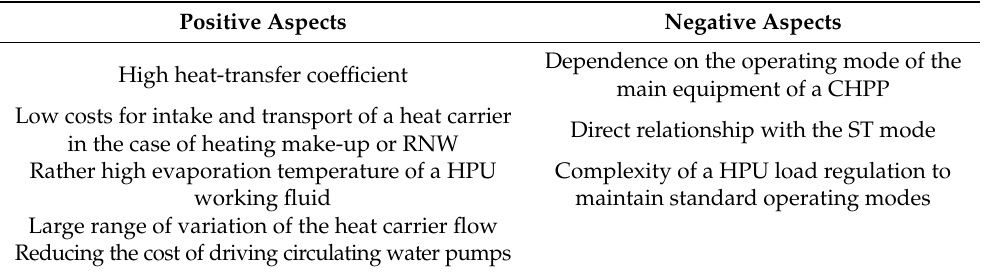
Table 4. Positive and negative aspects of using circulating water as a LPHS for HPUs.